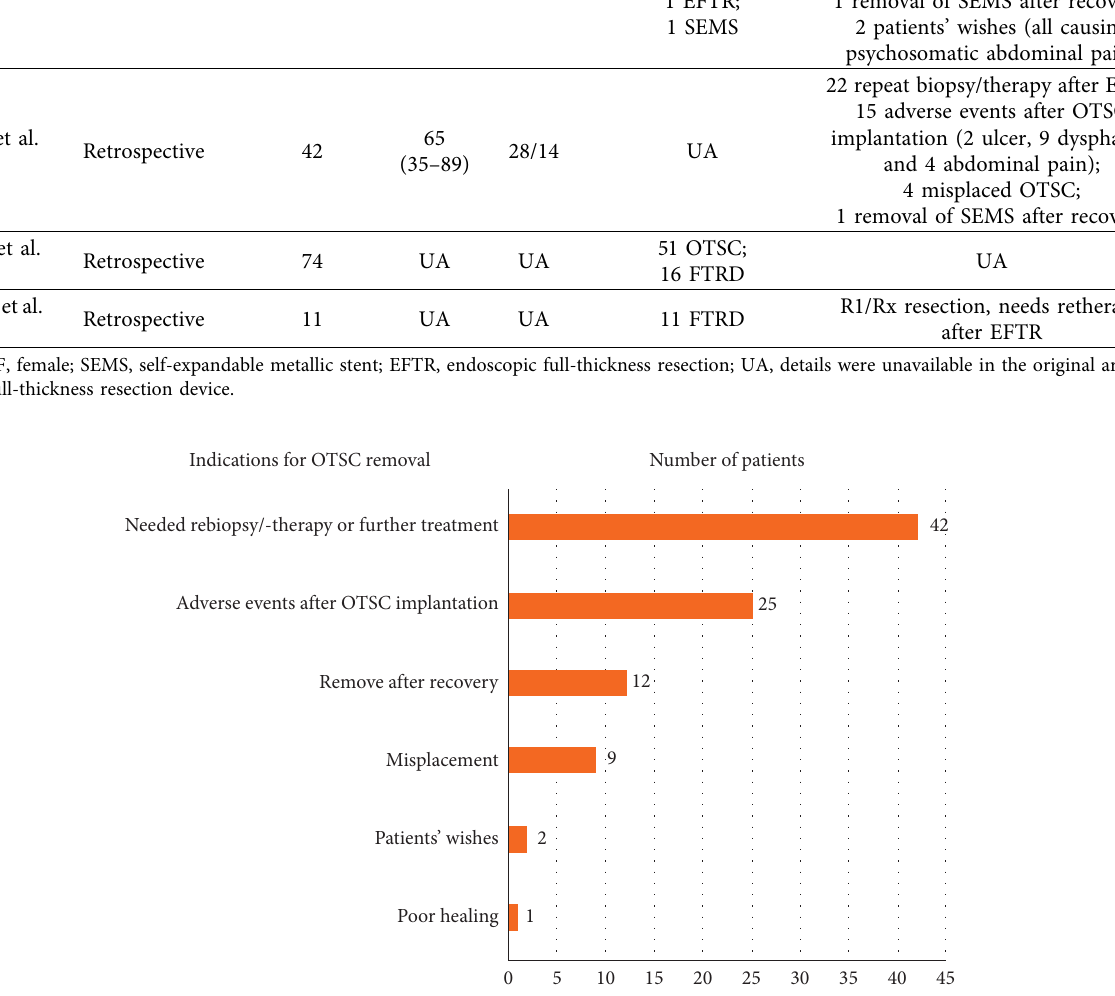
Figure 2: Distribution of indications for OTSC removal across the 17 studies ( n � 91). Caputo et al. [10] and Mumtaz et al. [17] were not included because indications of OTSC removals were unavailable in the